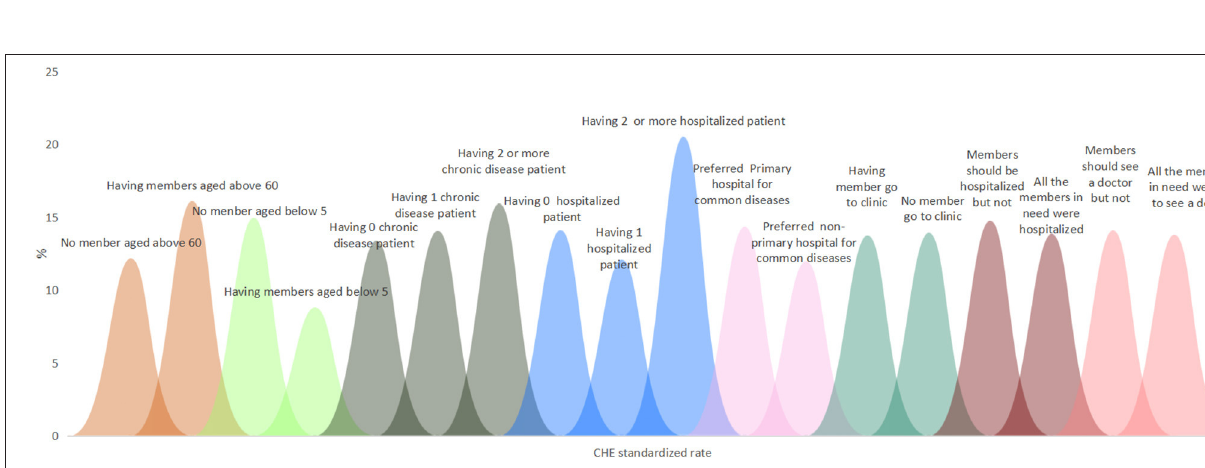
FIGURE 4 | The CHE standardized rate under the characteristics of single dimension related to health service need and utilization